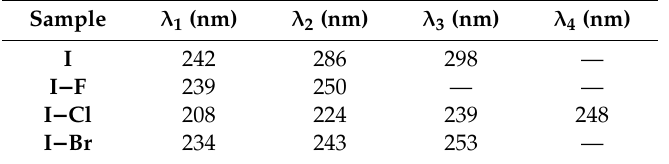
Table 4. Experimental wavelengths of I , I − F , I − Cl , and I − Br samples quantified by absorbance